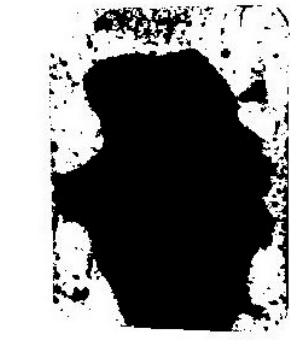
Figure 7. The image processing of test specimens with #110 asphalt and granite aggregate: ( a ) original image and ( b ) binary image.